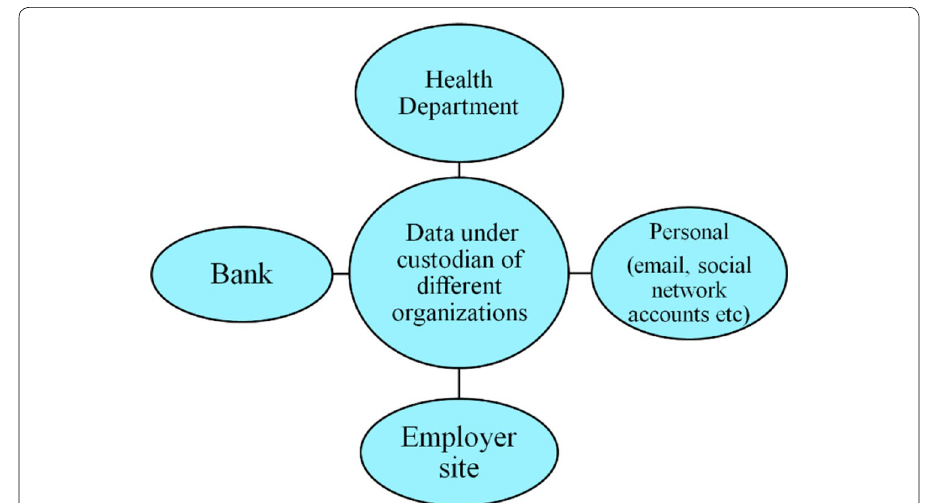
Fig. 2 Vertical distribution of person specific